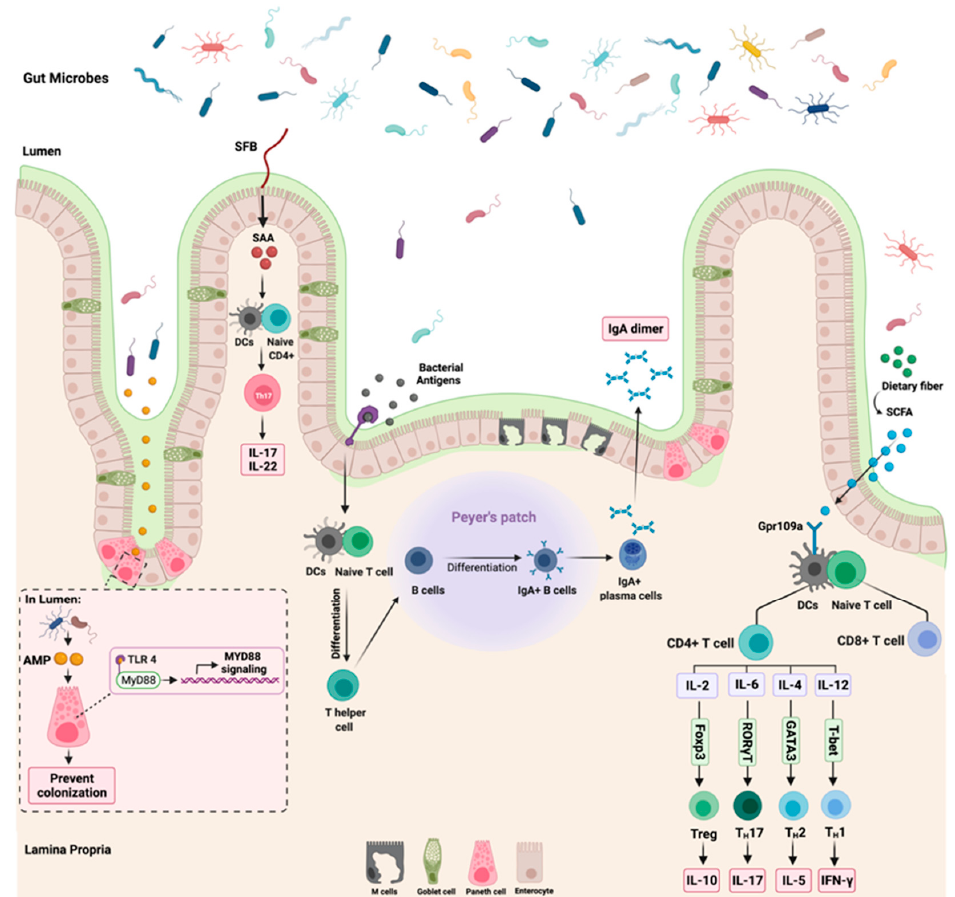
Figure 2. Summary of the most reported gut microbiome and immune interactions. While the left side of the figure illustrates the influence of segmented filamentous bacteria (SFB) and antimicrobial peptides (AMP) on the host immune system through the activation of Th17 and MyD88 signaling, respectively, the right section of the figure highlights the role of dietary fibers and short chain fatty acids (SCFA) on T cells expression. The role of bacterial antigens on the production of IgA dimer is shown in the middle part of the figure. “Created with BioRender.com”.